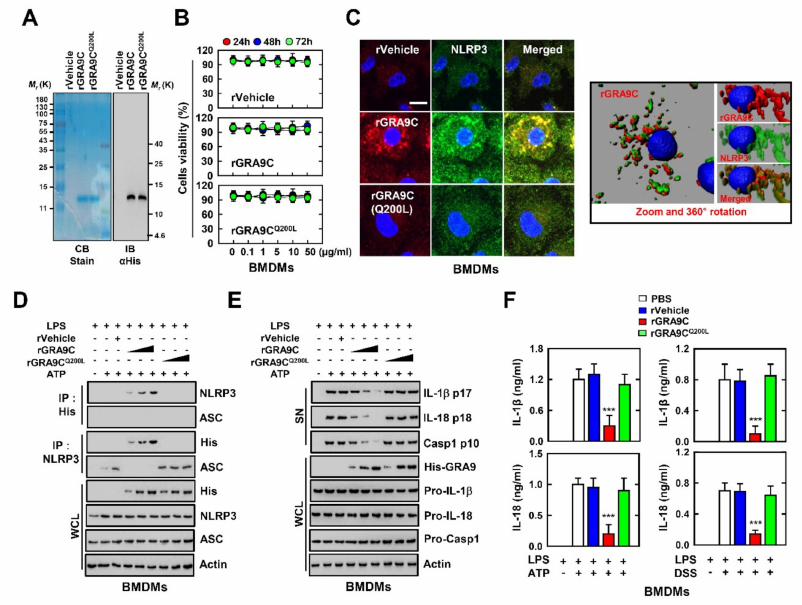
Figure 4. rGRA9C decreases the activation of NLRP3 inflammation by associating NLRP3. ( A ) Bacterially purified 6xHis-GRA9C and rGRA9C Q200L were analyzed by Coomassie blue staining (left) or immunoblotting (IB) with α His (right). ( B ) BMDMs were incubated with rGRA9C and rGRA9C Q200L for the indicated times and concentrations and cell viability measured with MTT assay. ( C ) BMDMs were treated with rVehicle, rGRA9C, or rGRA9C Q200L , and immunolabelled with α Flag (Alexa 586), α NLRP3 (Alexa 488) and DAPI and analyzed in three dimensions. ( D , E ) BMDMs were primed with LPS (100 ng mL − 1 ) and stimulated with ATP (5 mM) and rVehicle, rGRA9C or rGRA9C Q200L at various concentrations (0.1, 1, or 10 µ g / mL). Followed by IP with α His or α NLRP3 and immunoblotted with α NLRP3, α ASC or α His (D) or IB with in supernatant (SN) with α IL-1 β p17, α IL-18 p18, or α Casp1 p10 and WCL with α His, α Pro-IL-1 β , α Pro-IL-18, α Pro-Casp1, or α Actin ( E ). ( F ) BMDMs were primed with LPS (100 ng mL − 1 ) and stimulated with ATP (5 mM) or DSS (3%) and rVehicle, rGRA9C, or rGRA9C Q200L . The level of cytokines is analyzed by ELISA for IL-1 β , and